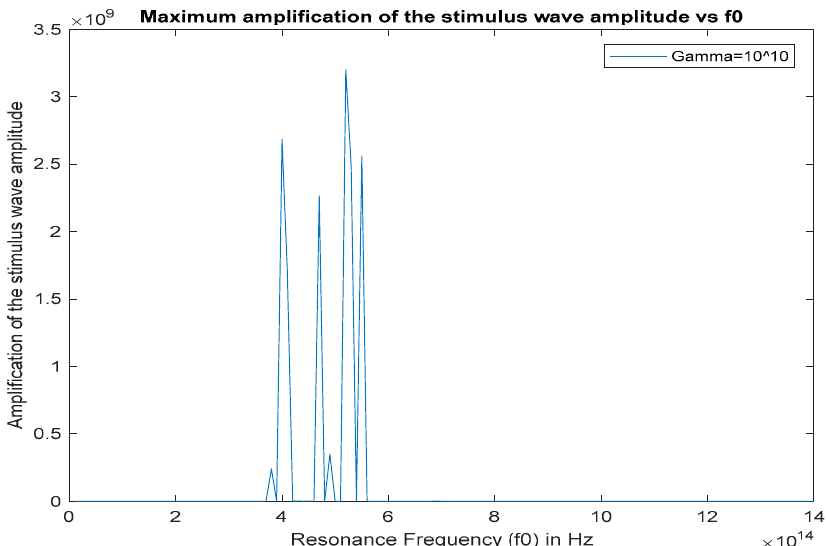
Figure 8. Maximum stimulus wave amplitude (gain factor) inside the cavity at x = 5.73 μ m for 0 < t < 30 ps, 𝛾 = 1 × 10 (cid:2869)(cid:2868) Hz , versus 𝑓 (cid:2868) .